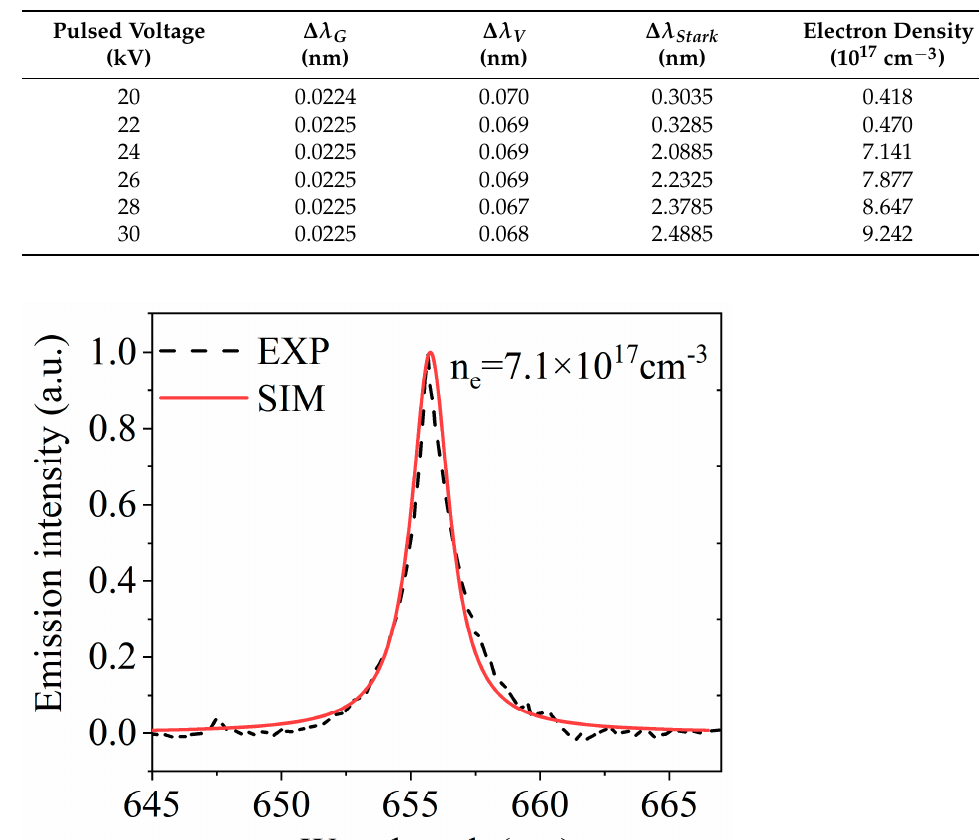
Table 2. The values of van der Waals broadening, Gaussian broadening, and Stark broadening of the H α line.